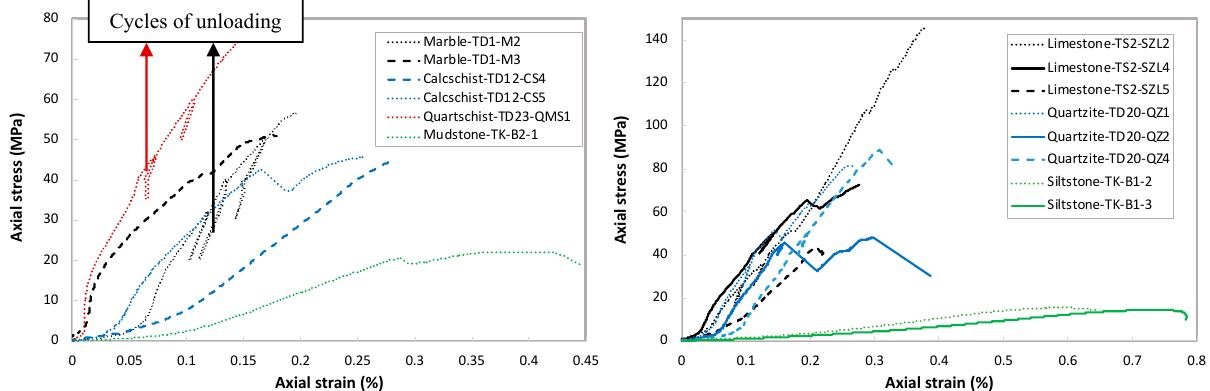
Figure 4. Axial stress–strain behaviour from the 14 UCS experiments performed. For some UCS tests, unloading cycles were also performed. For the limestone samples (black trends in bottom graph): note the variation in ultimate strength and stress–strain slope due to heterogeneity as a result of diagenesis.